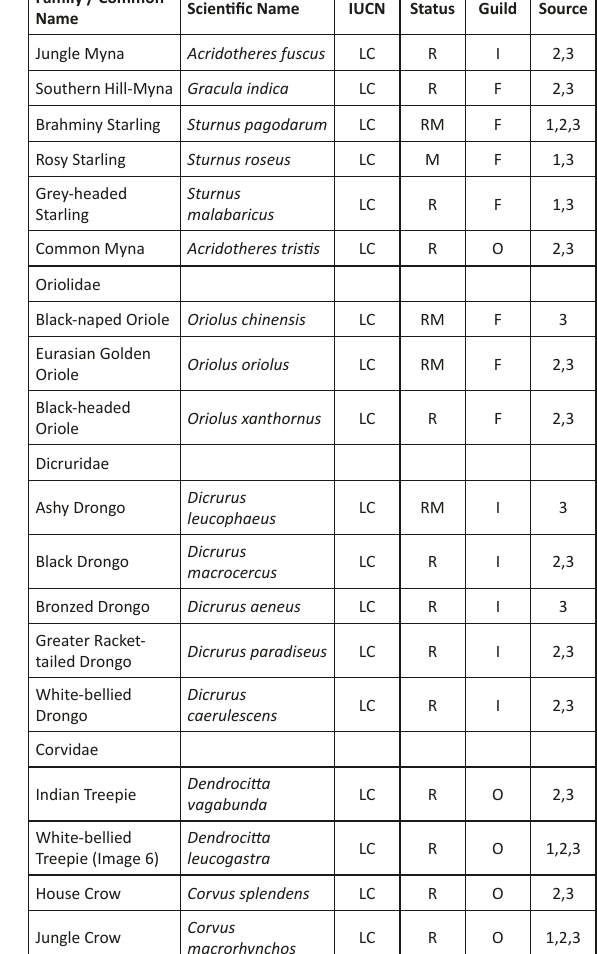
House Crow Corvus splendens LC R O 2,3 Corvus Jungle Crow macrorhynchos LC R O 1,2,3